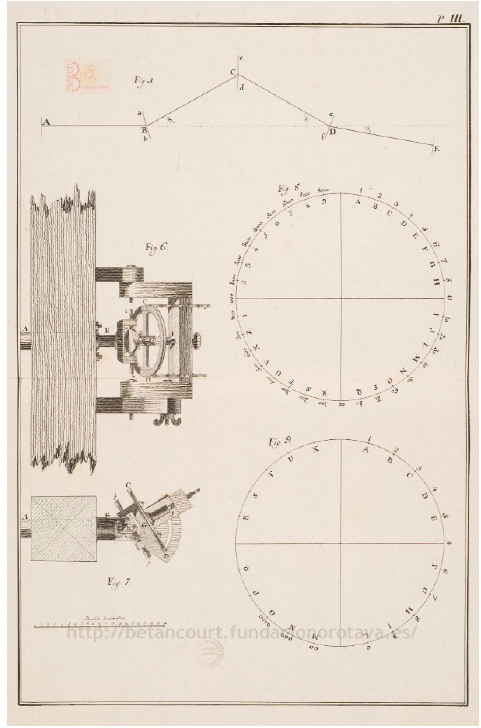
Figure 3. Observation angles and signal system of the optical telegraph by Agustín de Betancourt and Abraham Louis Breguet [18] (Courtesy of Fundación Canaria Orotava de Historia de la Ciencia).